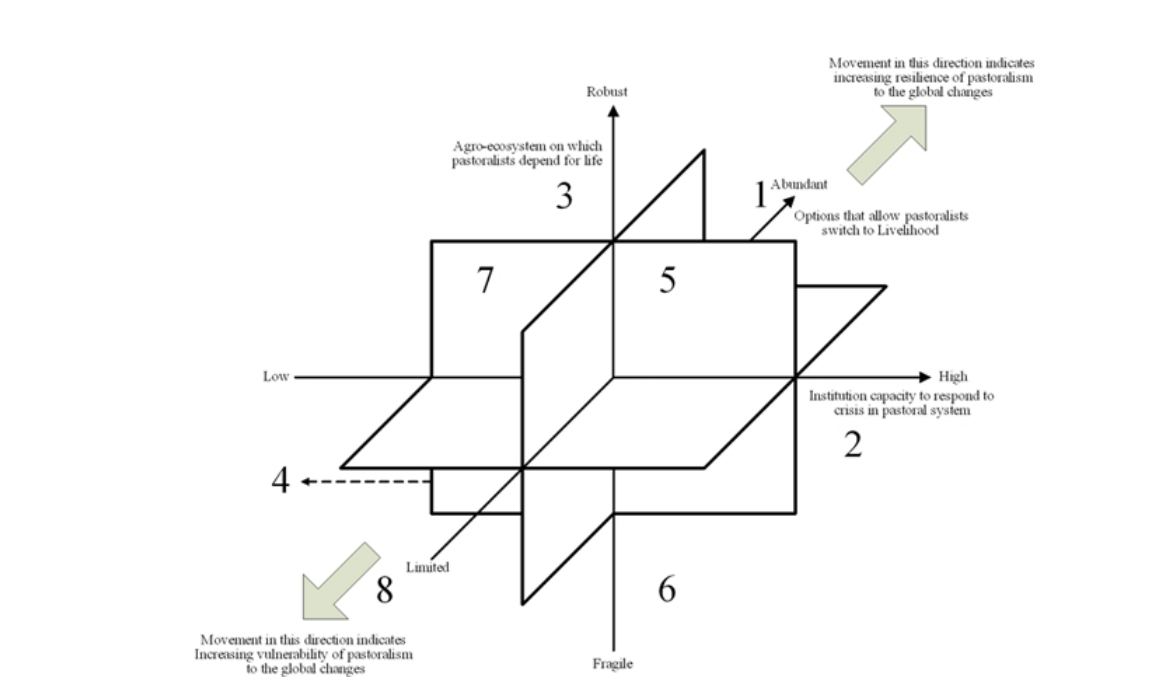
Fig. 1. Three-dimensional vulnerability-coordination framework in assessing vulnerability of pastoralism. In the dimensions of agroecosystems on which pastoralists depend, options that allow pastoralists to react and institution capacity to respond to crises in pastoral systems: octant 1 is robust, abundant, and high; octant 2 is fragile, abundant, and high; octant 3 is robust, abundant, and low; octant 4 is fragile, abundant, and low; octant 5 is robust, limited, and high; octant 6 is fragile, limited, and high; octant 7 is robust, limited, and low; octant 8 is fragile, limited, and low. At agroecological, livelihood, and institutional scales, the movement to octant 8 indicates increased vulnerability of pastoralism to global climate change and octant 1 implies decreased vulnerability of pastoralism to global climate change (Adapted from Fraser